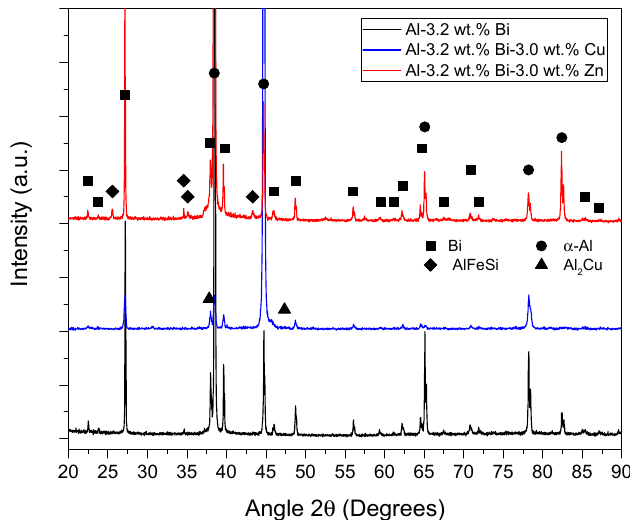
Figure 6. X-ray diffraction patterns performed on the Al-3.2 wt.% Bi, Al-3.2 wt.% Bi-3.0 wt.% Cu, and Al-3.2 wt.% Bi-3.0 wt.% Zn alloys samples solidified at cooling rates higher than 10 K/s.